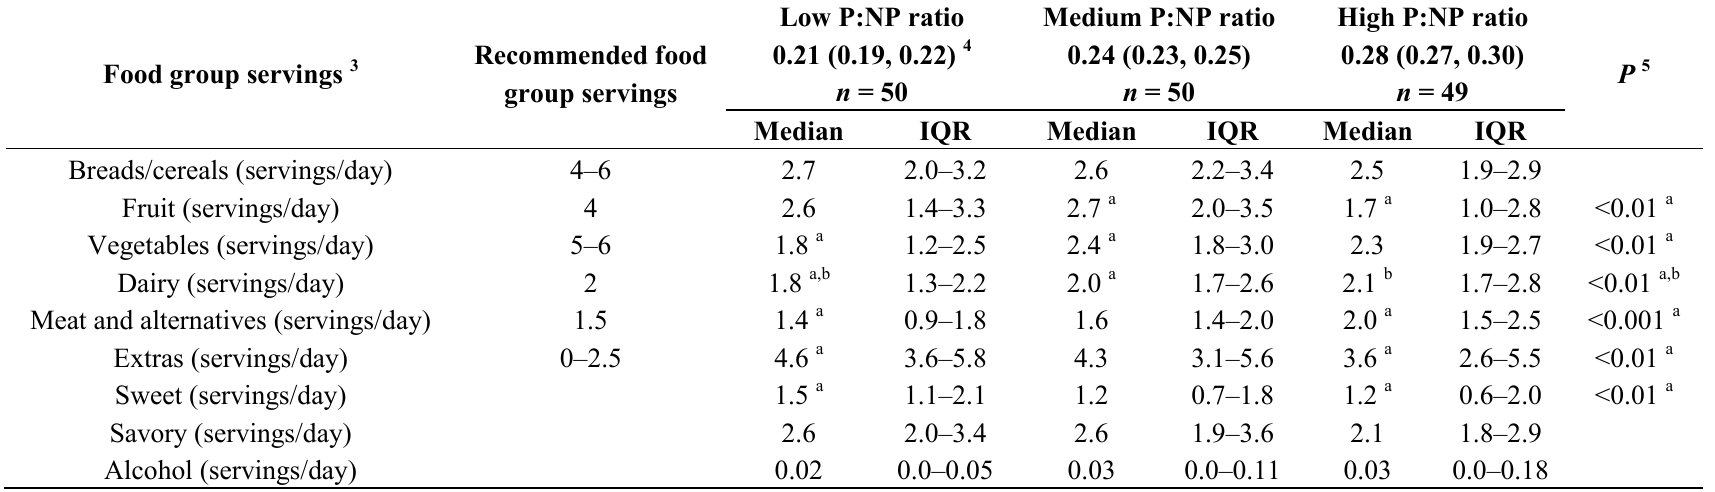
Table 3. Daily food group consumption during pregnancy for participants in the WATCH Study with plausible dietary data, by tertile of the protein to non-protein ratio ( n = 149) 1,2